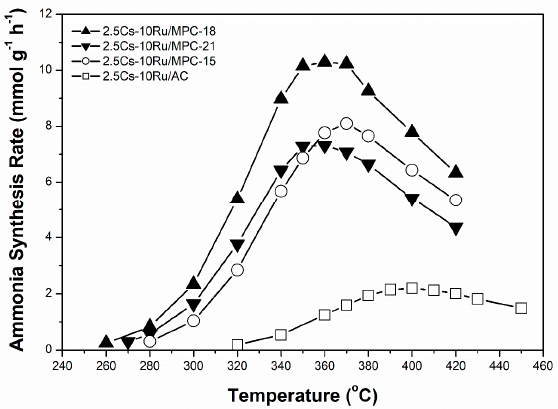
Figure 6. Rate of ammonia synthesis as a function of reaction temperature over the prepared Cs-Ru catalysts at an SV value of 9000 h − 1 .